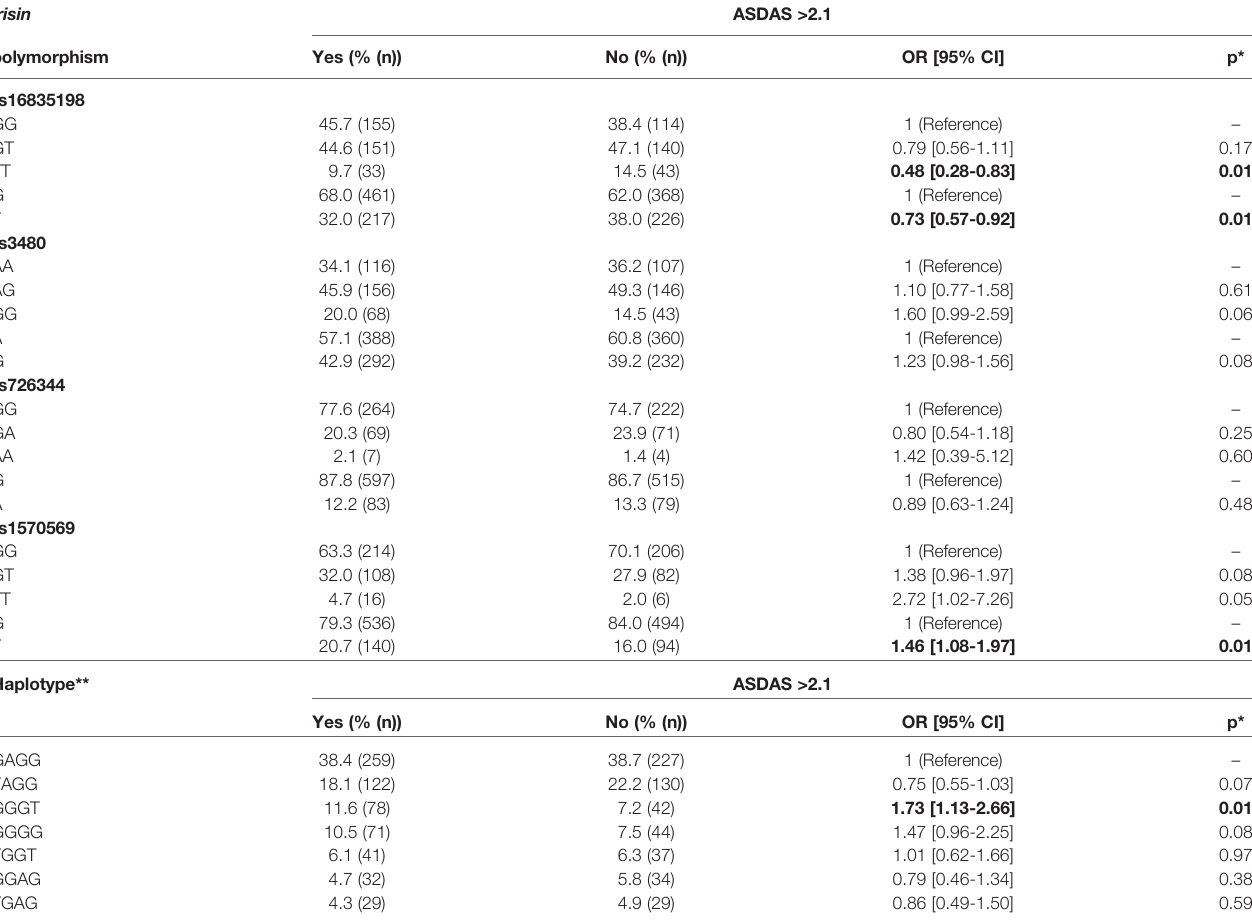
TABLE 2 | Genotypes, alleles and haplotypes of irisin according to ASDAS values >2.1 in axSpA patients. Irisin ASDAS